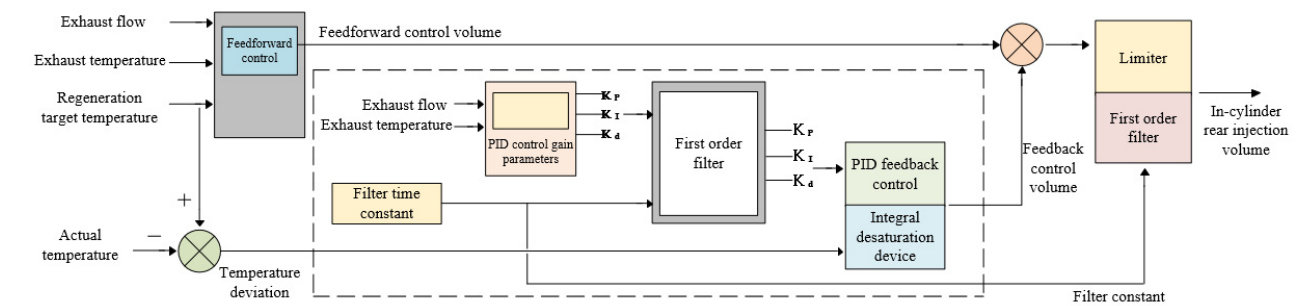
Figure 13. Diagram of the target regeneration temperature control algorithm.